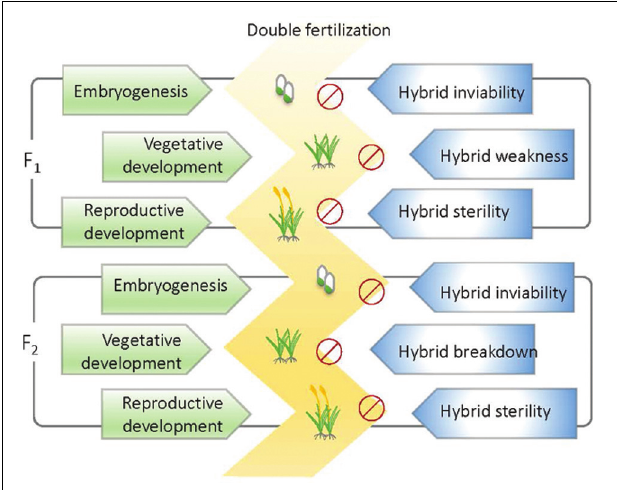
FIGURE 1 | Different forms of postzygotic reproductive isolation (RI).